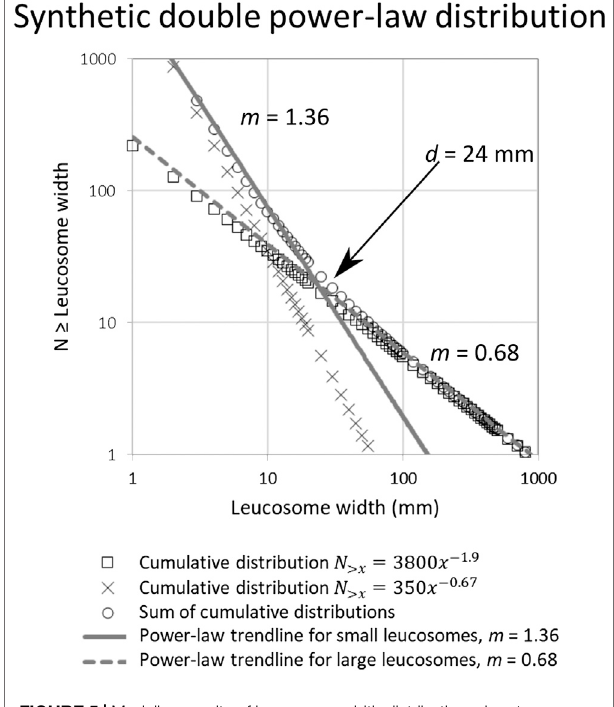
FIGURE 5 | Modeling results of leucosome width distribution when two untruncated power-law trends interfere with each other, comparable to the measured outcrop section ( Figure 4A ). This double power-law distribution with a negative kink can form when two sets of leucosomes following different width distributions interfere. For the kink to be visible, the two distributions must have substantially different exponents m , and the total amount of leucosomes on the trend with the lower m value must be considerably lower than on the trend with the higher m value.